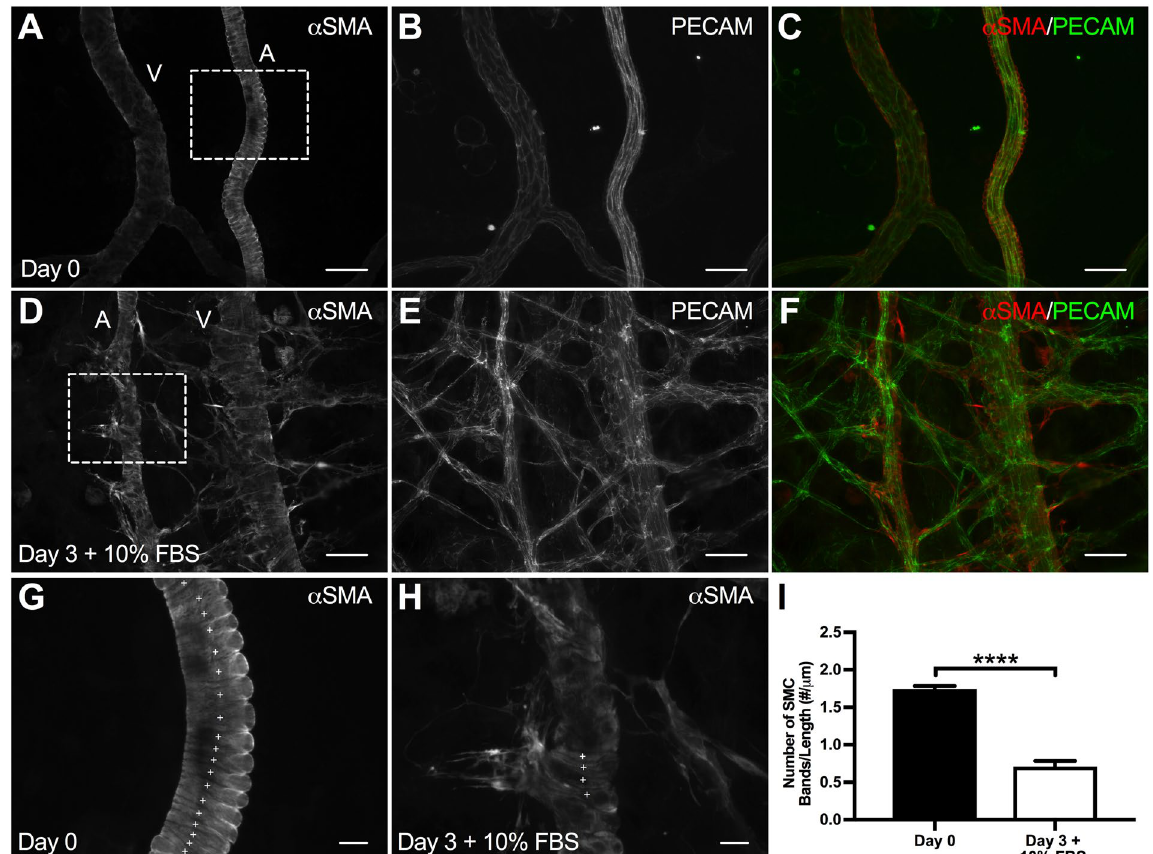
Figure 4. Evaluation of smooth muscle cell morphology in the rat mesentery culture model. ( A–F ) Comparison of Day 0 and Day 3 + 10% FBS SMC morphology. PECAM and α SMA labeling identified increased EC sprouting and decreased SMC bands after three days in culture with 10% FBS compared to bands in Day 0 tissues. Scale bars = 50 μ m. A = arteriole, V = venule. ( G–I ) Evaluation of SMC bands, where ( G , H ) are higher magnifications of the tissue regions indicated by the squares shown in ( A ) and ( D ) respectiveley. Comparison of Day 0 and Day 3 + 10% FBS tissues reveals a decrease in SMC bands after three days in culture with serum. Plus signs identify SMC bands. Scale bars = 10 μ m. Black and white bars represent Day 0 and Day 3 + 10% FBS groups respectively. **** indicates a significant difference of p < 0.0001 by two-tailed Student’s